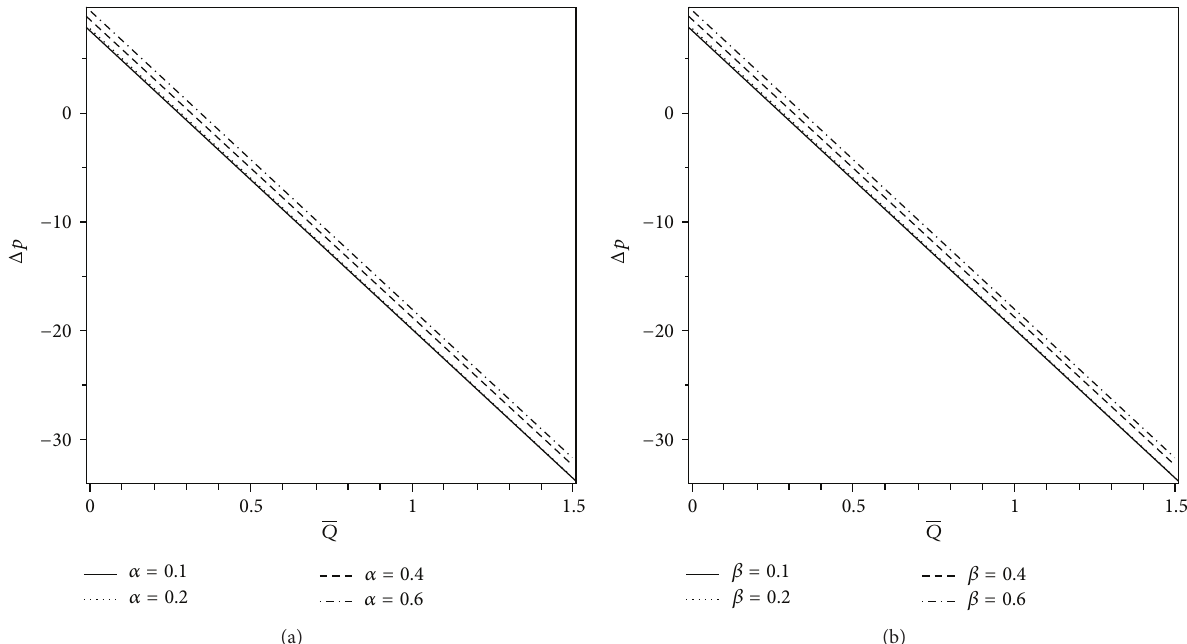
Figure 3: Variations of Δ𝑝 with 𝑄 for different values of (a) 𝛼 when 𝛽 = 0.4 and (b) 𝛽 when 𝛼 = 0.4 . The other parameters are 𝐻 𝑝 = 0.09 and 𝜀 = 0.25 .